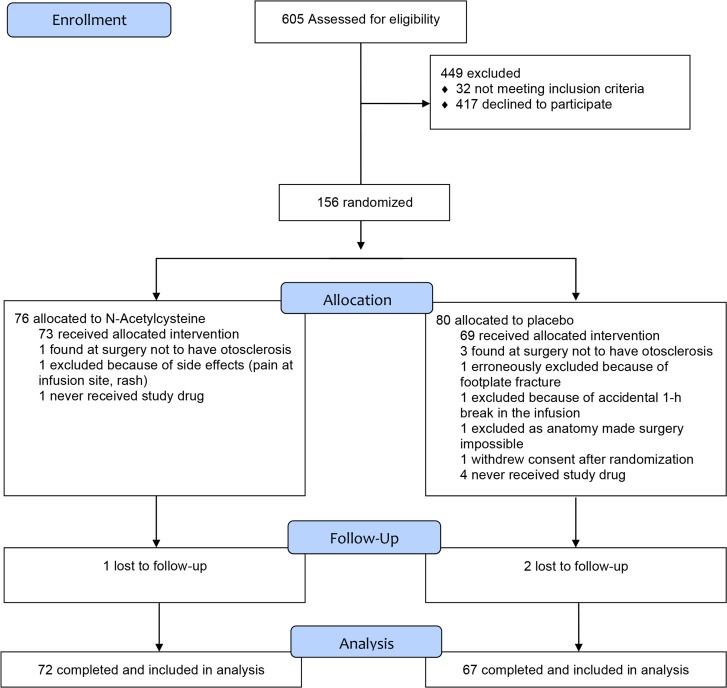
Consort flow diagram.A common reason for declining trial participation was that long travel distances made patients unwilling to return to the hospital for the 1-year follow-up visit. Otosclerosis is a clinical diagnosis, and 4 patients were found at surgery to have middle ear disorders where stapedotomy is not indicated. One patient in the placebo group was excluded in violation of the protocol because of a fracture of the stapes footplate. A total of 5 patients never received the study drug because their operations were postponed after study drugs had been delivered to the ward (but before drug infusion started).